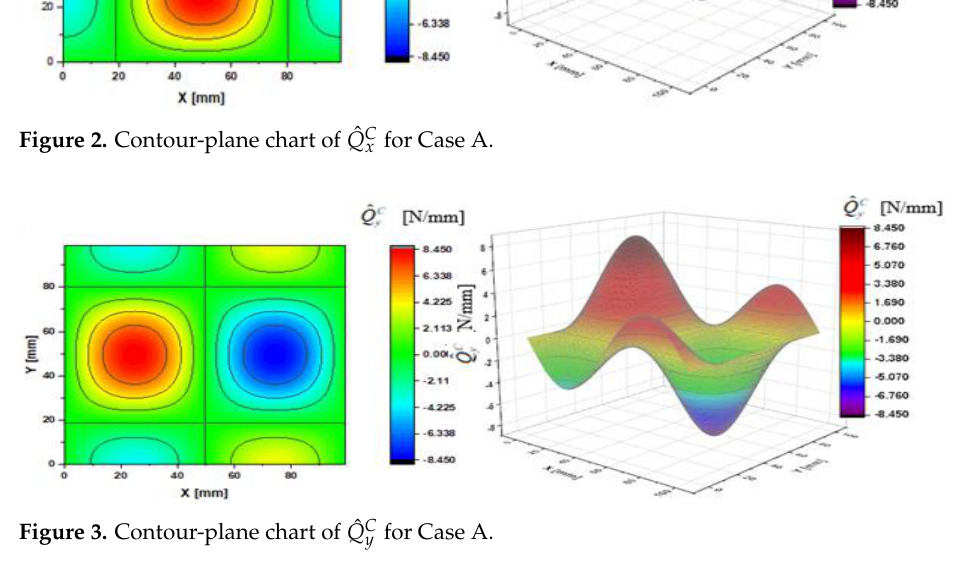
Q ˆ for Case A. Q ˆ for Case A. y Q ˆ for Case A. y y